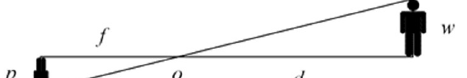
Figure 9. Flow chart of event-based tracking by improved KCF.